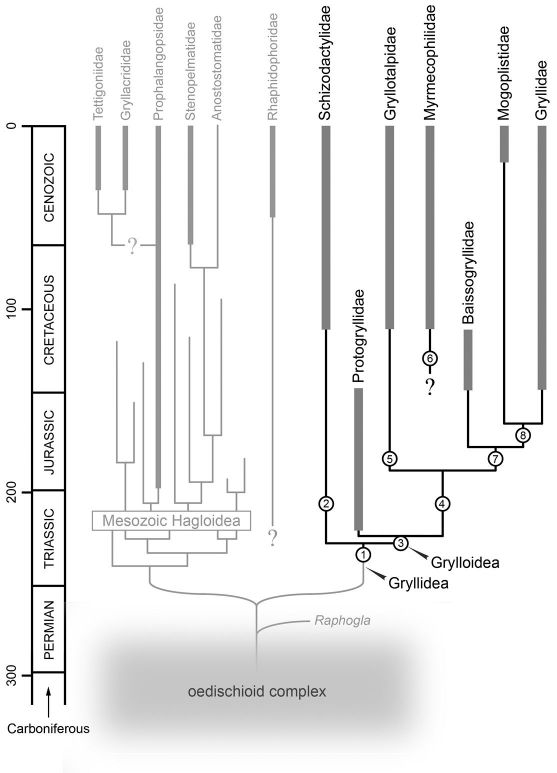
Competing hypotheses of ensiferan relationships, after: a – Ander (1939); b – Zeuner (1939); c – Ragge (1955); d – Sharov (1968); e – Gorochov (1995a, b); f– Gwynne (1995); g– Desutter-Grandcolas (2003); h– Jost and Shaw (2006); i – Legendre et al. (2010).